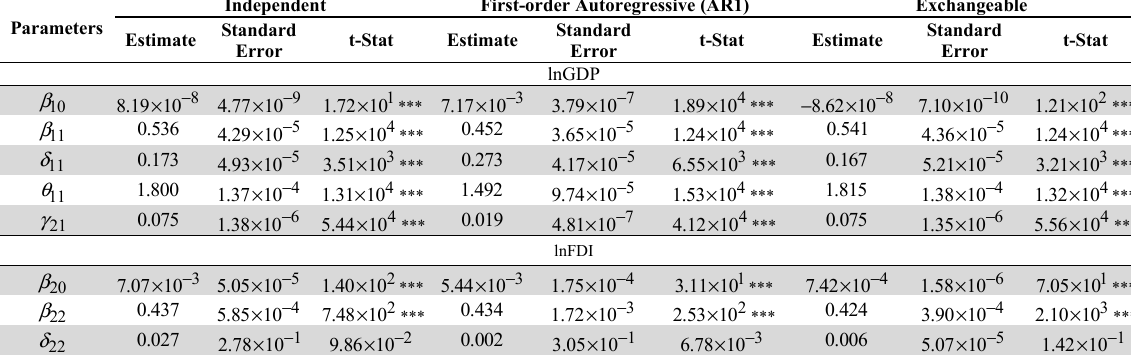
Parameter estimation results on simultaneous spatial durbin panel model